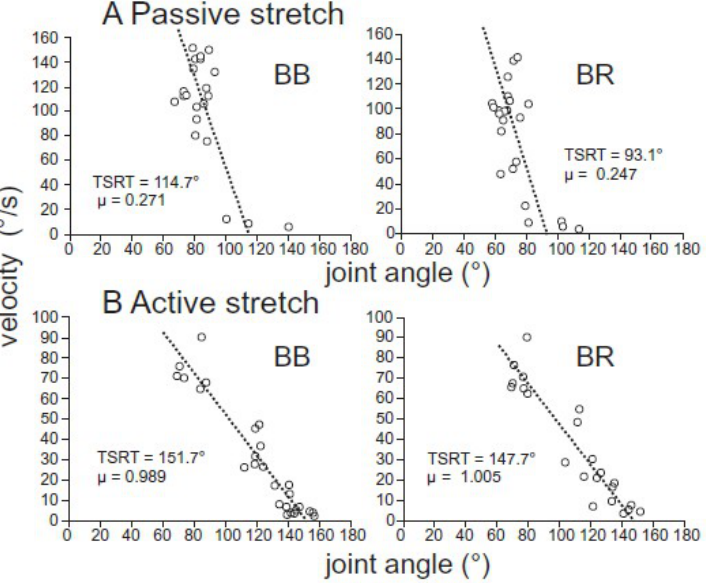
Figure 6. A representative subject in [84] where in the active stretching of elbow flexors—biceps brachii (BB) and brachioradialis (BR)—the TSRTs were found to occur at greater joint angle or higher stretch. In contrast, the sensitivity to velocity was found to be increased in both muscles, when compared to passive motion.